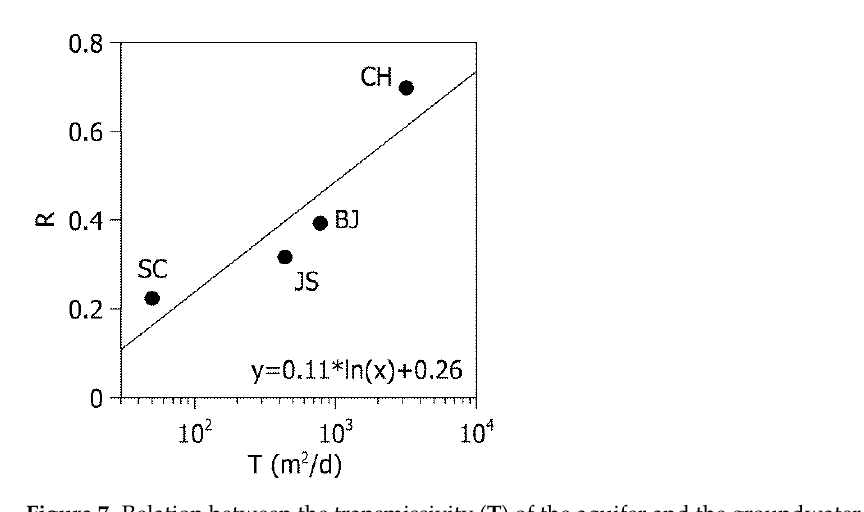
Figure 7. Relation between the transmissivity ( T ) of the aquifer and the groundwater level response rate ( R ) following a change in the river level.